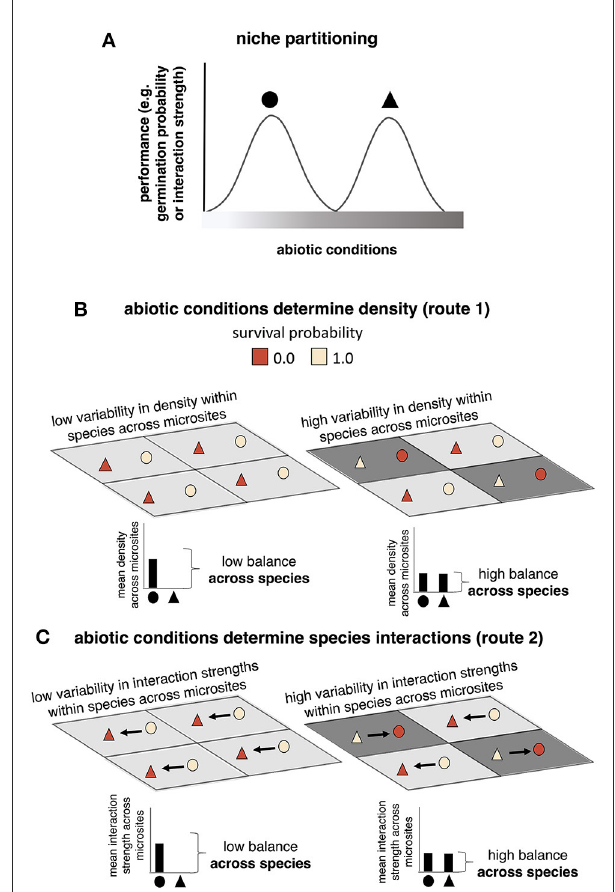
FIGURE1 The two routes of abiotic influence under niche partitioning. In (A) we introduce a simple community of two species, circles and triangles, with unique responses to an abiotic factor. In (B) , we show how those unique responses influence the initial density of species in a landscape with low compared to high abiotic heterogeneity. Both landscapes have four “patches” that correspond to microsites with abiotic conditions shown in grayscale. The landscape with low abiotic heterogeneity is on the left and does not include any patch in which the triangle species can germinate. The landscape with high abiotic heterogeneity is on the right and includes patches where either circles or triangles can germinate depending on abiotic conditions. In the low heterogeneity landscape, triangles die everywhere and circles survive everywhere, resulting in low variability in density for each species across the landscape. In the high heterogeneity landscape, circles and triangles both die in some patches but germinate in others, resulting in high variability in density for each species across the landscape. Below each landscapes we quantify the mean density across microsites experienced by each species. When species have different means we can say there is low balance across species, and high balance when their means are similar. In (C) , abiotic conditions affect interaction strengths between germinated seedlings, shown as arrows, instead of density, but predicted effects are the same as discussed above for (B) . Individuals colored dark red are present as seeds but either cannot germinate (B) or germinate but die later during competitive interactions (C)